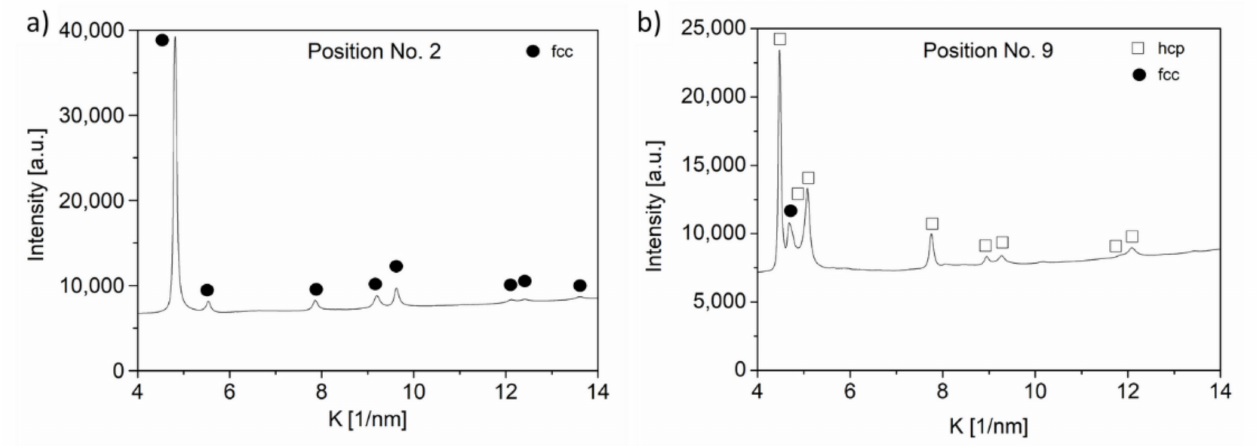
Figure 4. Diffraction patterns for point Nos. 2 ( a ) and 9 ( b ). The intensity is plotted as a function of the reciprocal space variable K = 2sin θ / λ , where θ is the Bragg angle and λ is the wavelength of X-rays.